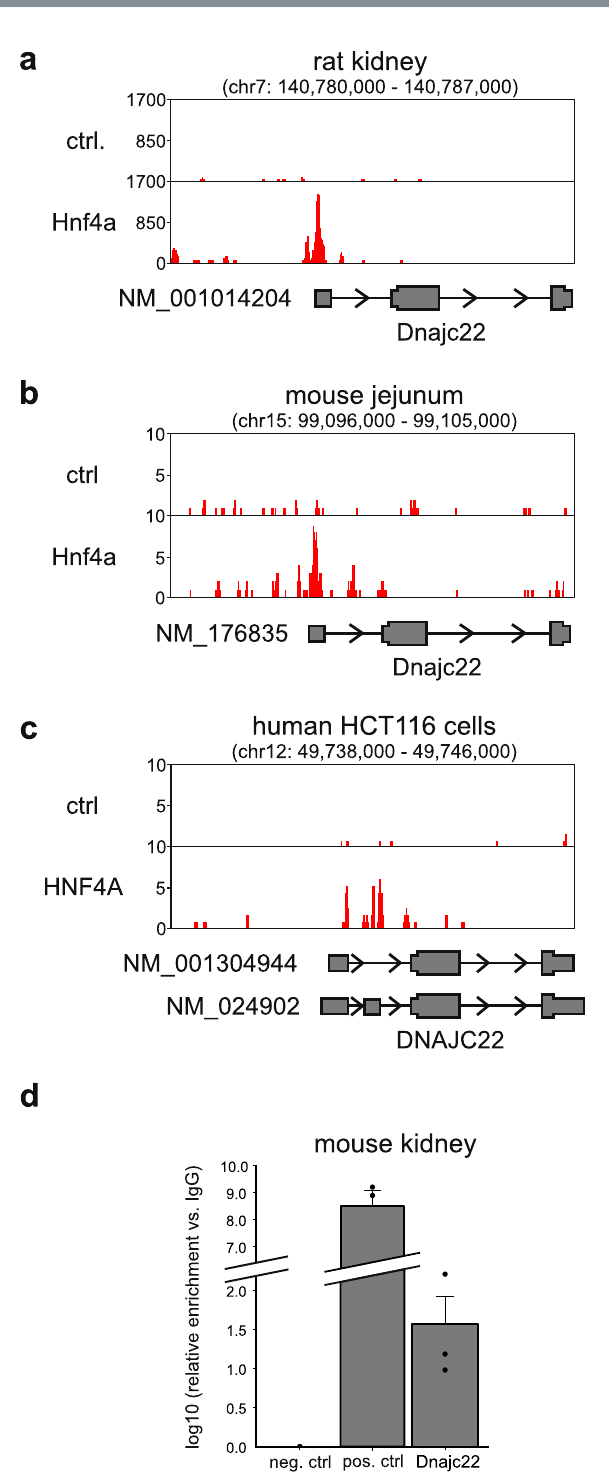
Figure 3. Hnf4a binds at the Dnajc22 locus. ChIP-seq peaks for Hnf4a at the rat Dnajc22 locus in kidney tissue ( a ), at the murine Dnajc22 locus in samples from intestine ( b ), and for HNF4A at the human DNAJC22 locus in human colon carcinoma (HCT116) cells ( c ). ( d ) HNF4A ChIP-qPCR of murine kidney cortex samples showing an enrichment of Hnf4a binding to the identified Dnajc22 promoter fragment. The Apoc3 promoter serves as a positive, a region in exon 9 of Hprt1 as a negative control. The significance of the enrichment was determined using a one-sided one-sample